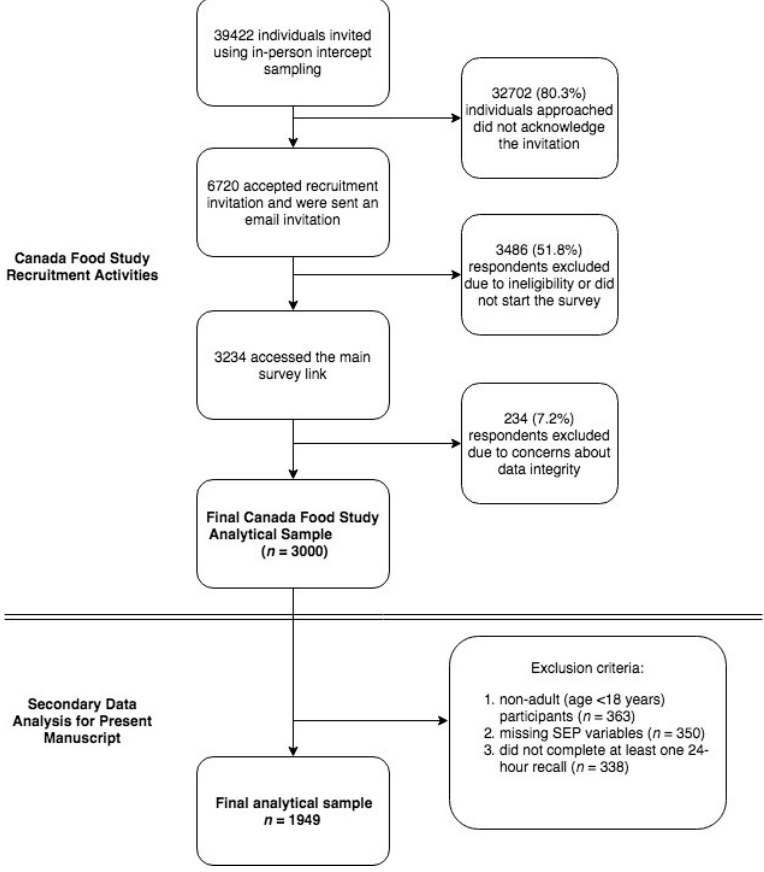
Figure 1. Flowchart describing Canada Food Study (CFS) sample selection and sample selection for the present analysis. SEP: socioeconomic position.